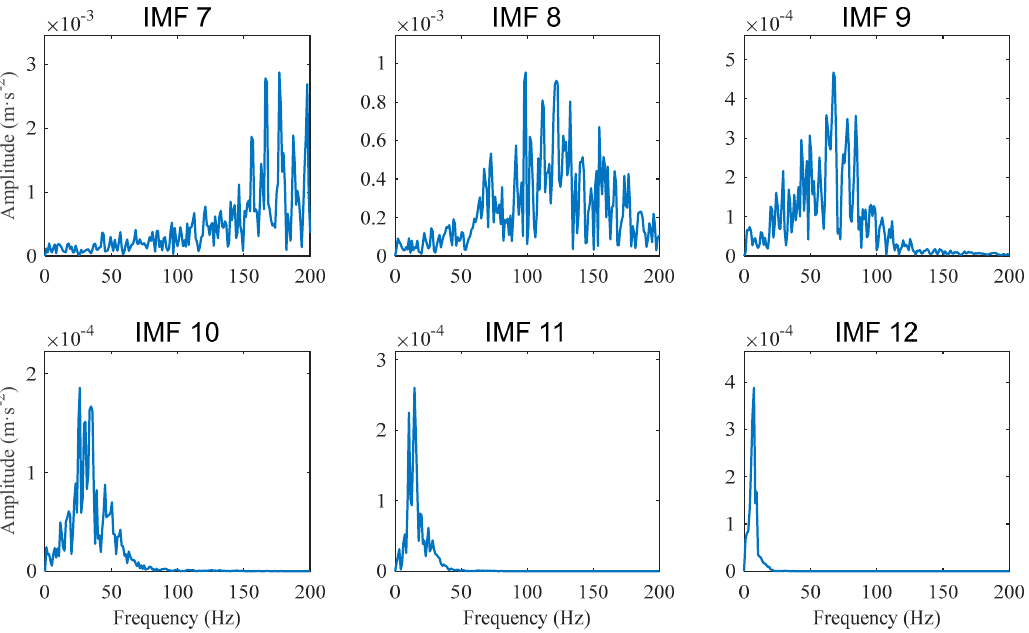
Figure 9. Case 1 for outer race defect: Amplitude spectra of IMFs obtained from an original signal segment that has the same samples as the compressed signal.